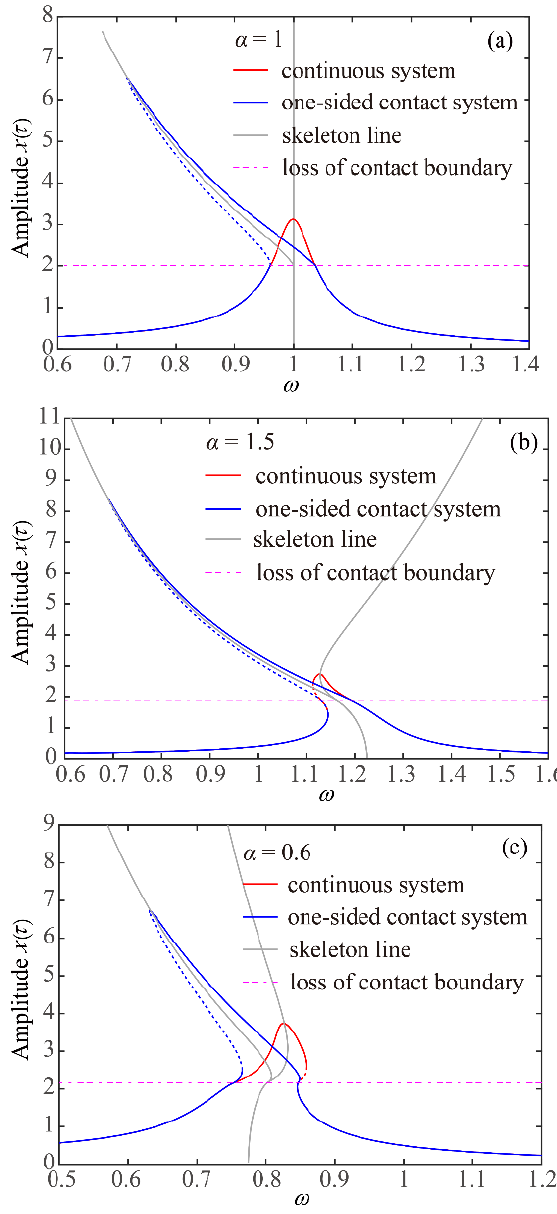
Figure 5. Comparisons of frequency-response peak-to-peak curves between continuous system and one-sided contact system, ( a ) α = 1, ( b ) α = 1.5, and ( c ) α = 0.6, where the magenta dash line denotes the loss contact boundaries.